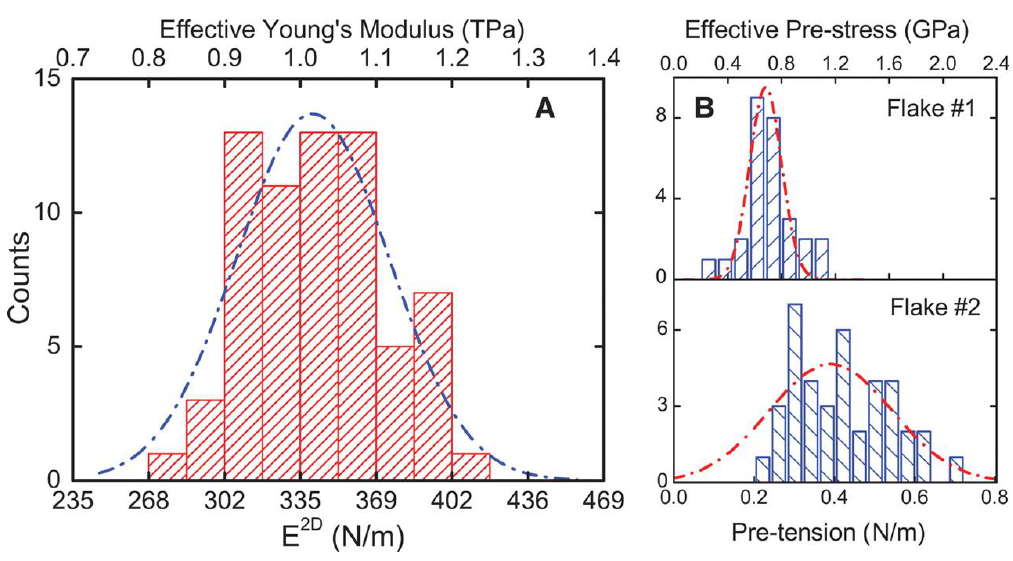
Figure 1. Elastic response test results. ( A ) Histogram of elastic stiffness. ( B ) Histogram of film pretensions. Dashed lines in both plots represent Gaussian fits to data. The effective Young’s modulus and prestress were obtained by dividing the graphite interlayer spacing Reproduced, adapted and reprinted with permission from Reference [23] .